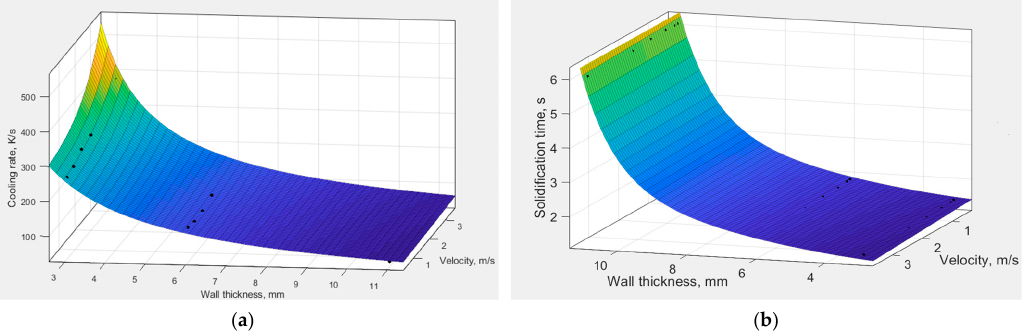
Figure 7. Influence of wall thickness and plunger velocity on cooling rate ( a ) and alloy solidification time ( b ).